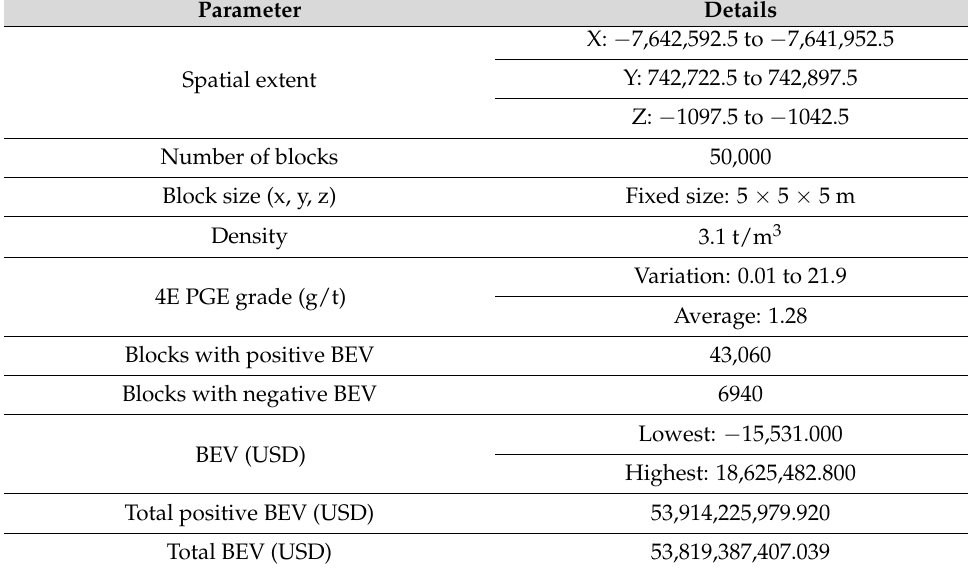
Figure 1. Synthetic Platreef block model with the legend showing BEV in USD. Source: [3]. Table 1. Synthetic Platreef block model specifications. Source [3].